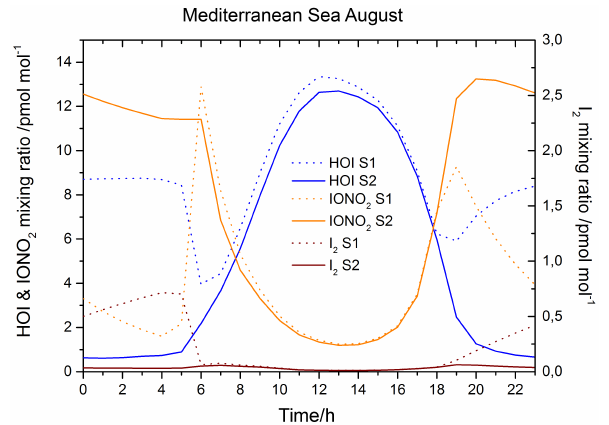
Figure 10. Hourly averaged concentration of HOI, IONO 2 and I 2 in the Mediterranean Sea at the surface level (long: 10 → 20 ◦ E, lat: 33 → 40 ◦ N)